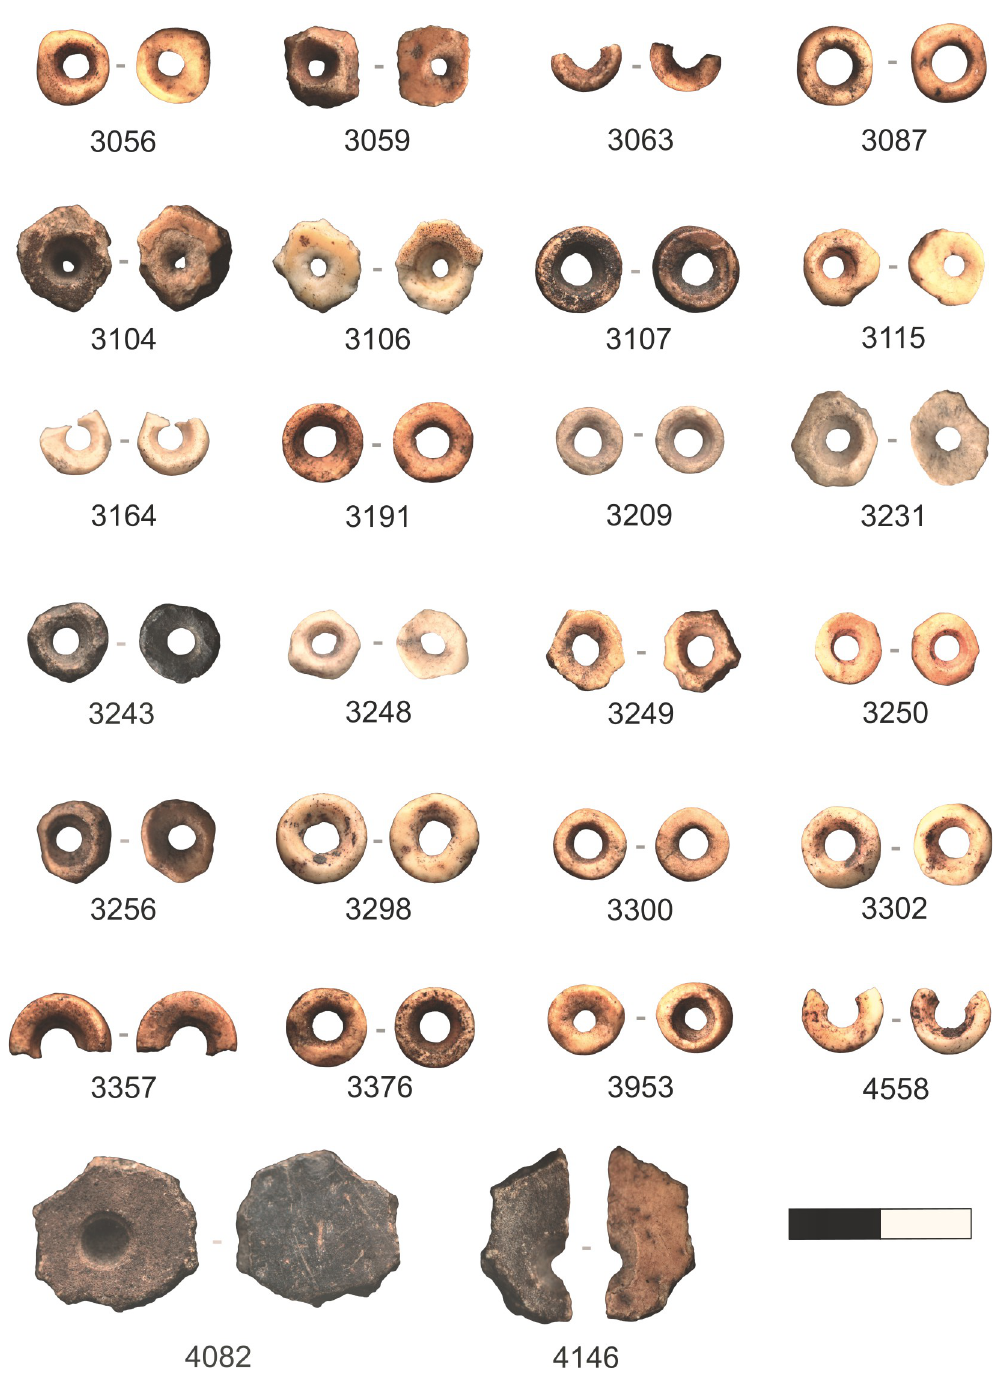
Fig 2. OES beads and preforms from Layer DBGS at Ga-Mohana Hill North Rockshelter. Find 4082 was potentially manufactured following Pathway 2. Scale divisions are 5mm. Twenty-one (21) OES fragments were recovered from the DBGS layer at GHN (S3 Table). The fragments have a mean length of 14.6 mm (range = 9.69 to 21.95, sd = 2.9), a mean width of 10 mm (range = 4.58 to 14.73, sd = 2.6) and a mean weight of 0.49 g (range = 0.12 to 0.84,